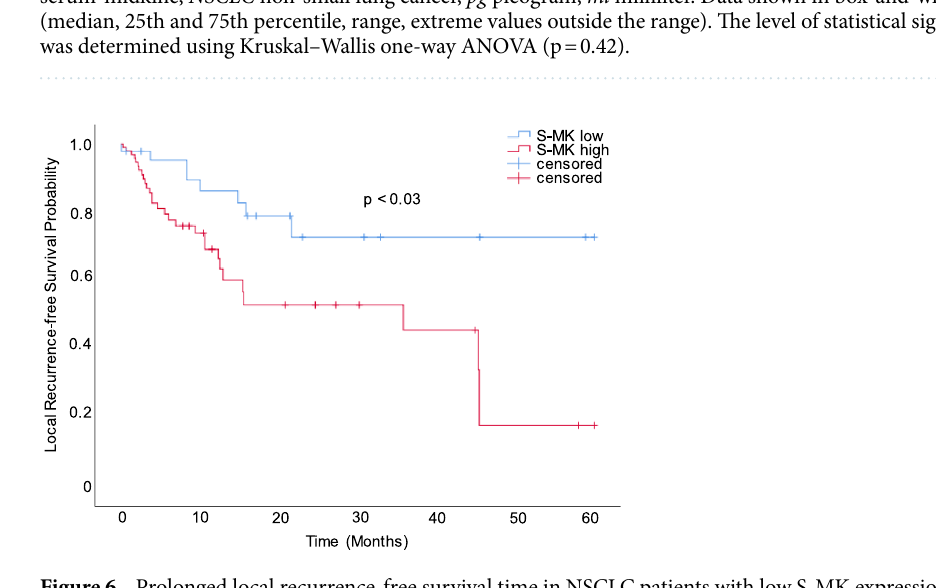
Figure 6. Prolonged local recurrence-free survival time in NSCLC patients with low S-MK expression compared to high S-MK expression. Abbreviations: S-MK serum-midkine, NSCLC non-small lung cancer. Kaplan–Meier curve comparing local recurrence-free survival of NSCLC patients with low (S-MK < 6.71 log pg/ ml; n = 22) and high s-MK levels (S-MK ≥ 6.71 log pg/ml; n = 37). Patients were followed up for 5-years post- surgery. Statistical difference was determined using the log-rank test (p <